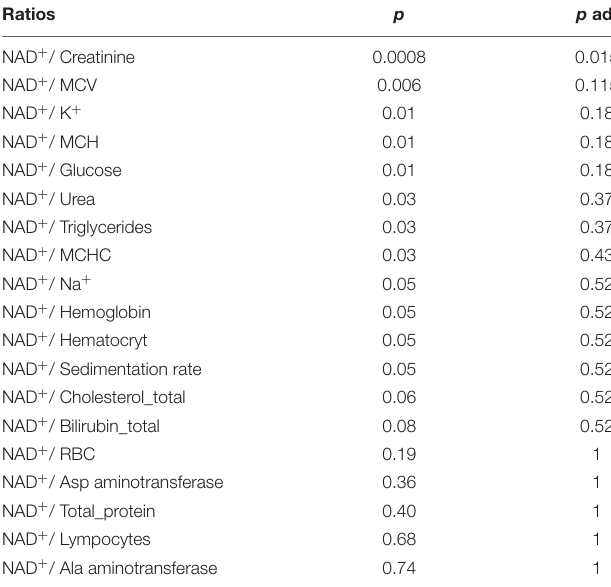
TABLE 2 | Discriminating power of the ratios of NAD + content to other blood